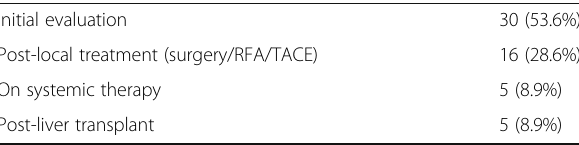
Table 2 Status of patients at time of FDG PET CT, n (%), total = 56 Initial evaluation 30 (53.6%)